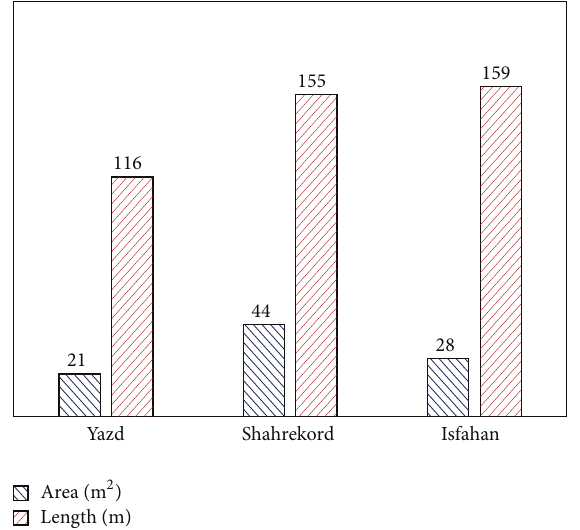
Figure 18: Average required PV area and GSHX length.